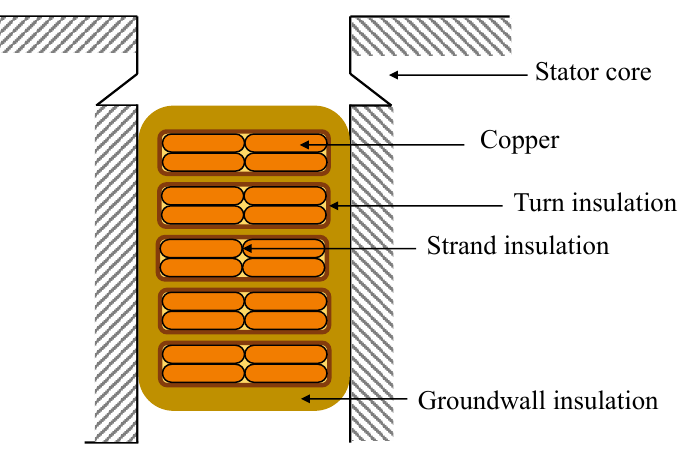
Figure 2. Insulation system of stator